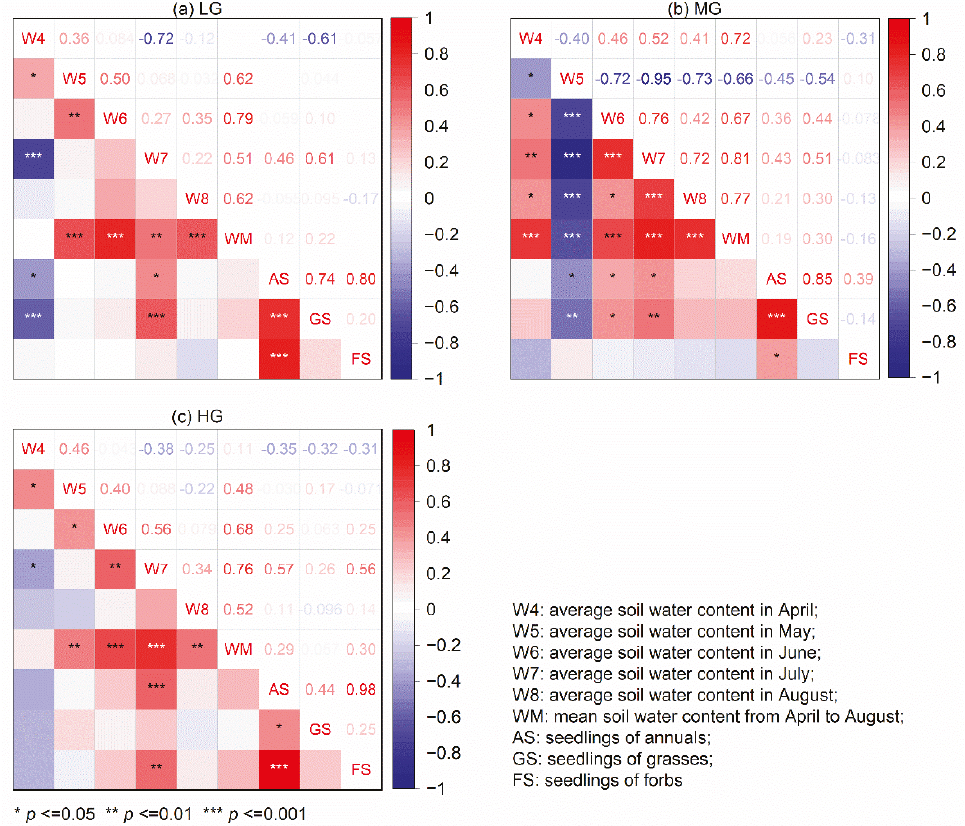
Figure 8. Pearson correlations between the seedling emergence and the monthly soil water content under the different grazing intensities. ( a ) Correlations in LG; ( b ) Correlations in MG; ( c ) Correlations in HG.